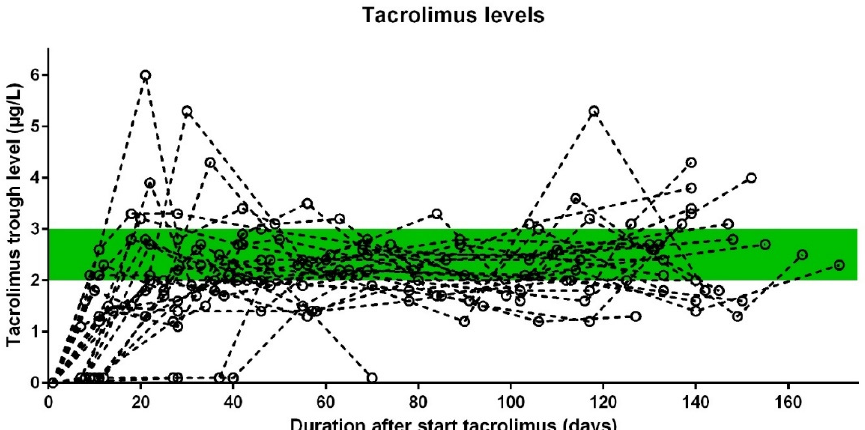
Figure 3. Tacrolimus trough levels for each patient.